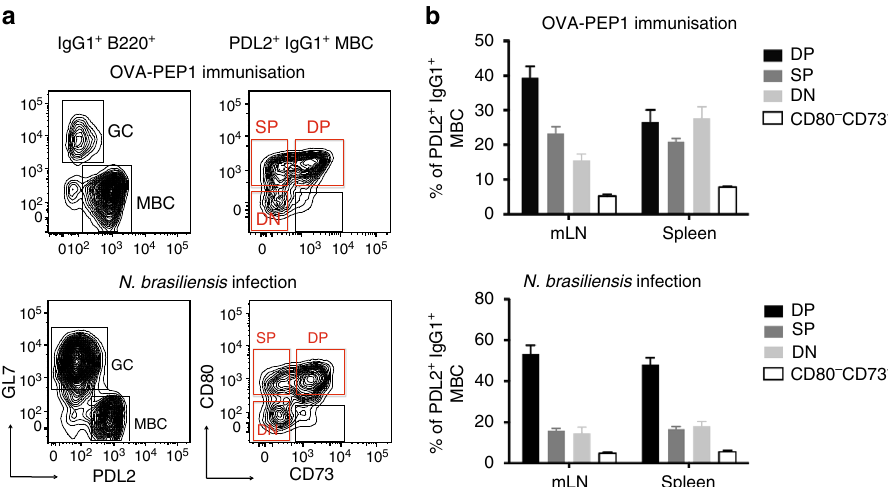
Fig. 1 Diversity of IgG1 memory B cells (MBC) in type 2 responses. a , b IgG1 + MBC subsets in spleen and mesenteric LN (mLN) of TBmc mice immunised with OVA-PEP1 (OVA-PEP1 immunisation), and of BALB/c mice infected with Nippostrongylus brasiliensis ( N.brasiliensis infection) at 10 weeks after treatment. The samples in each group were pooled, pre-enriched by depletion of IgD + , CD138 + and CD3 + cells. a Frequency of GL7 + germinal centre (GC) cells and PDL2 + MBC among gated IgG1 + B220 + cells ( left ), and identi fi cation of CD73 + CD80 + (DP), CD73 – CD80 + (SP) and CD73 − CD80 − (DN) IgG1 MBC subsets ( right ). b Frequency of CD73 + CD80 + (DP), CD73 – CD80 + (SP), CD73 − CD80 – (DN) and CD73 + CD80 – cells among gated PDL2 + IgG1 + MBC from OVA-PEP1 immunised TBmc mice ( top ) or N.brasiliensis infected BALB/c mice ( bottom ). Data are mean ± SEM of 5 OVA-PEP1 immunisation experiments and six N.brasiliensis infection